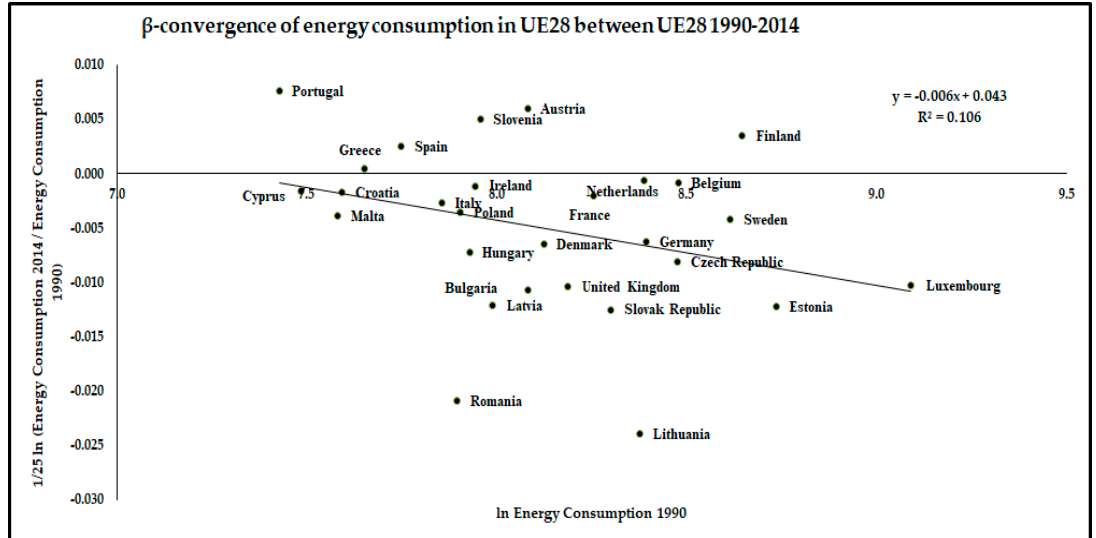
Figure 4. β -convergence of energy consumption in UE28 1990–2014 (Model 4).